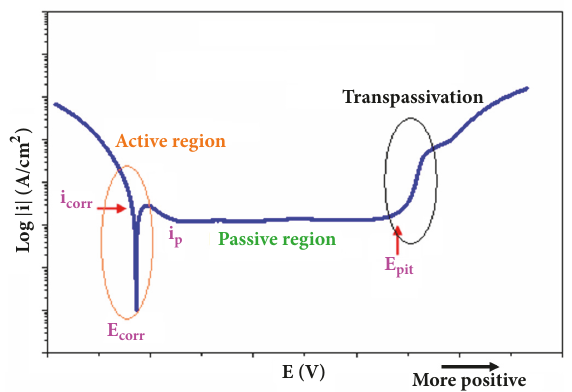
Figure 3: Typical Polarization curve of a passive material showing the active, passive, and transpassive